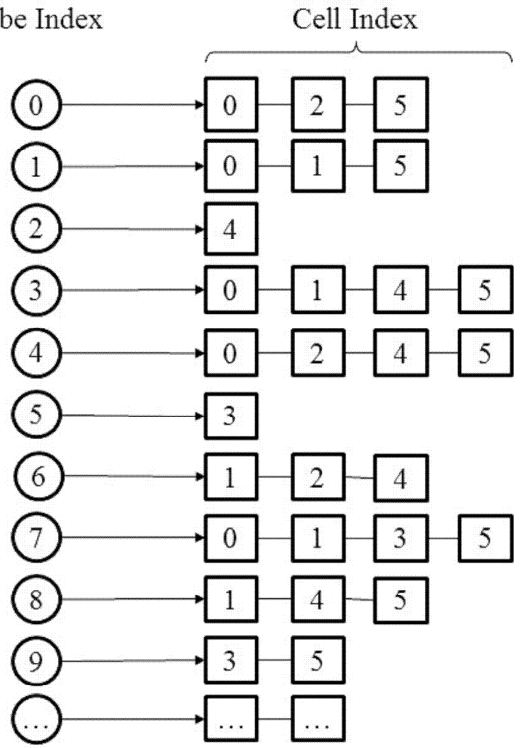
Figure 6. An illustration of a cube2cell list.